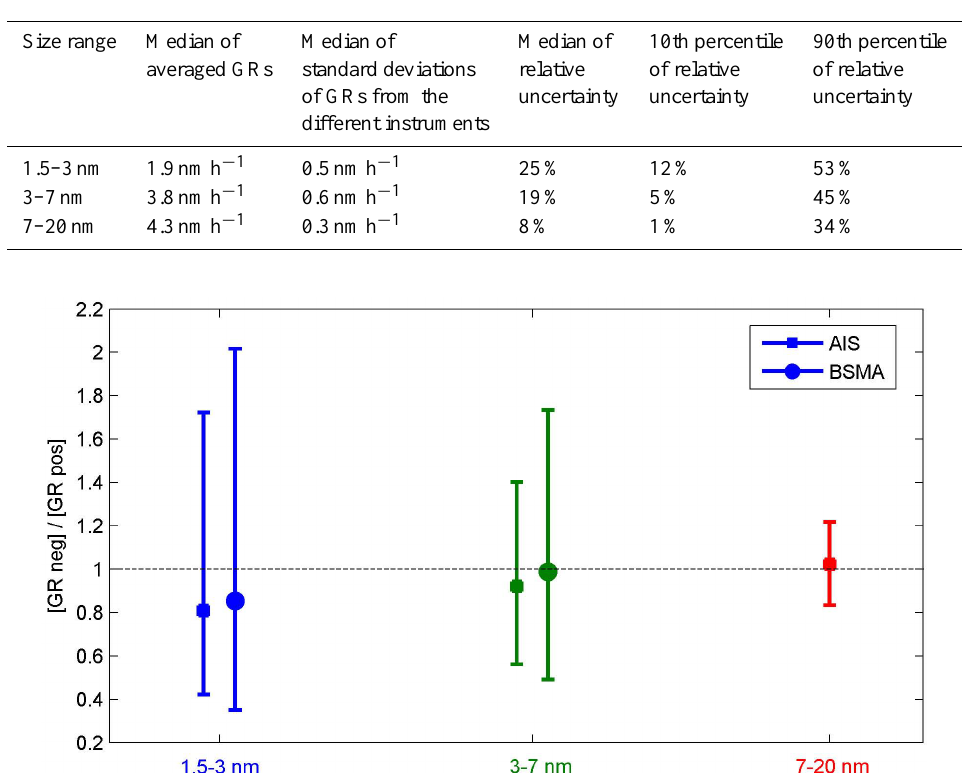
Table 3. The medians over the 81month long measurement period of the particle growth rates averaged from those obtained from the three instruments (DMPS, BSMA and AIS), the medians of the standard deviations between the growth rates obtained from different instruments and the medians and 10th and 90th percentiles of the relative uncertainty of the growth rate values.